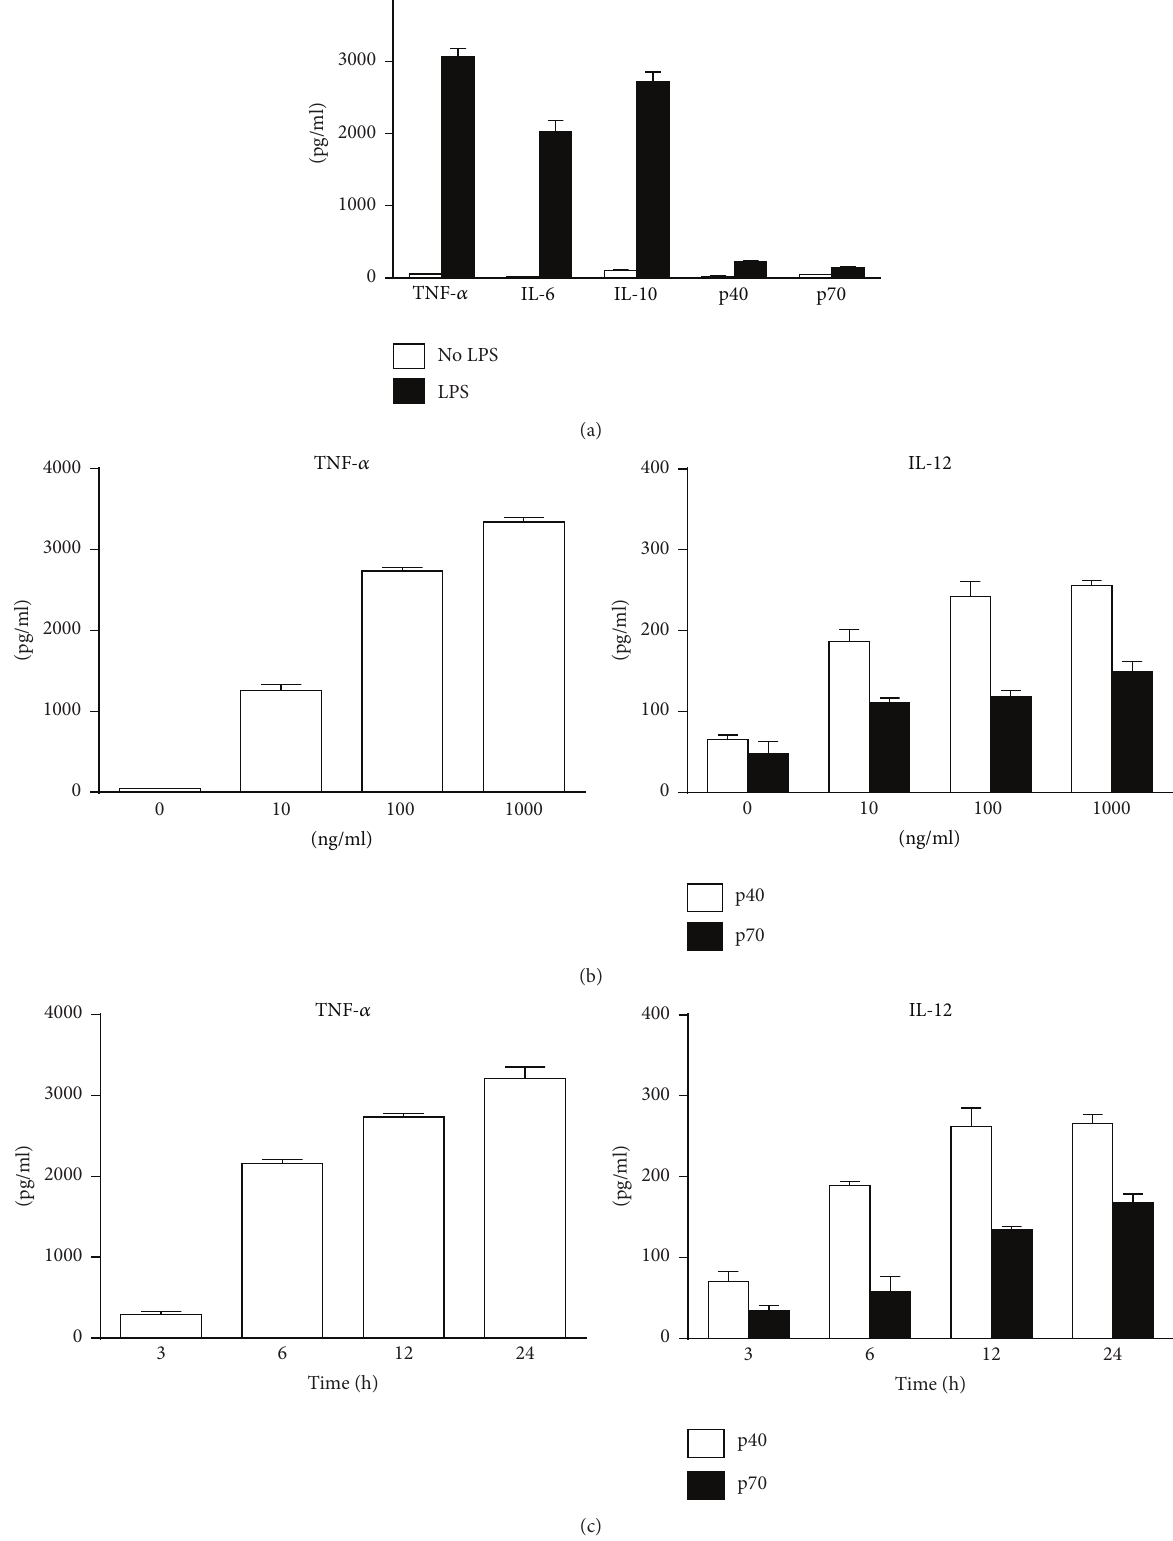
Figure 1: LPS induces the low levels of IL-12 in murine peritoneal macrophages. (a) Murine peritoneal macrophages were treated with or without 100 ng/mL LPS for 24 h. Supernatant levels of TNF- 𝛼 , IL-6, IL-10, IL-12 p40, and IL-12 p70 were detected by ELISA. (b, c) Peritoneal macrophages were treated with LPS (0, 10, 100, and 1000 ng/mL) for 24 h (b) or with 100 ng/mL LPS for 3, 6, 12, and 24h (c). Supernatant levels of TNF- 𝛼 and IL-12 p40/p70 were detected by ELISA ( 𝑛 = 3